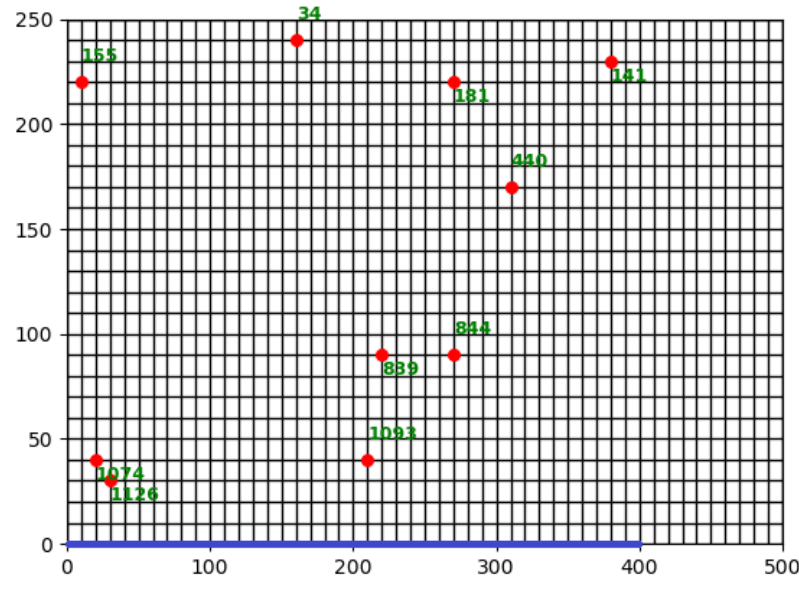
Figure 4—Map view plot of the fracture network and 10 sampled nodes in Case